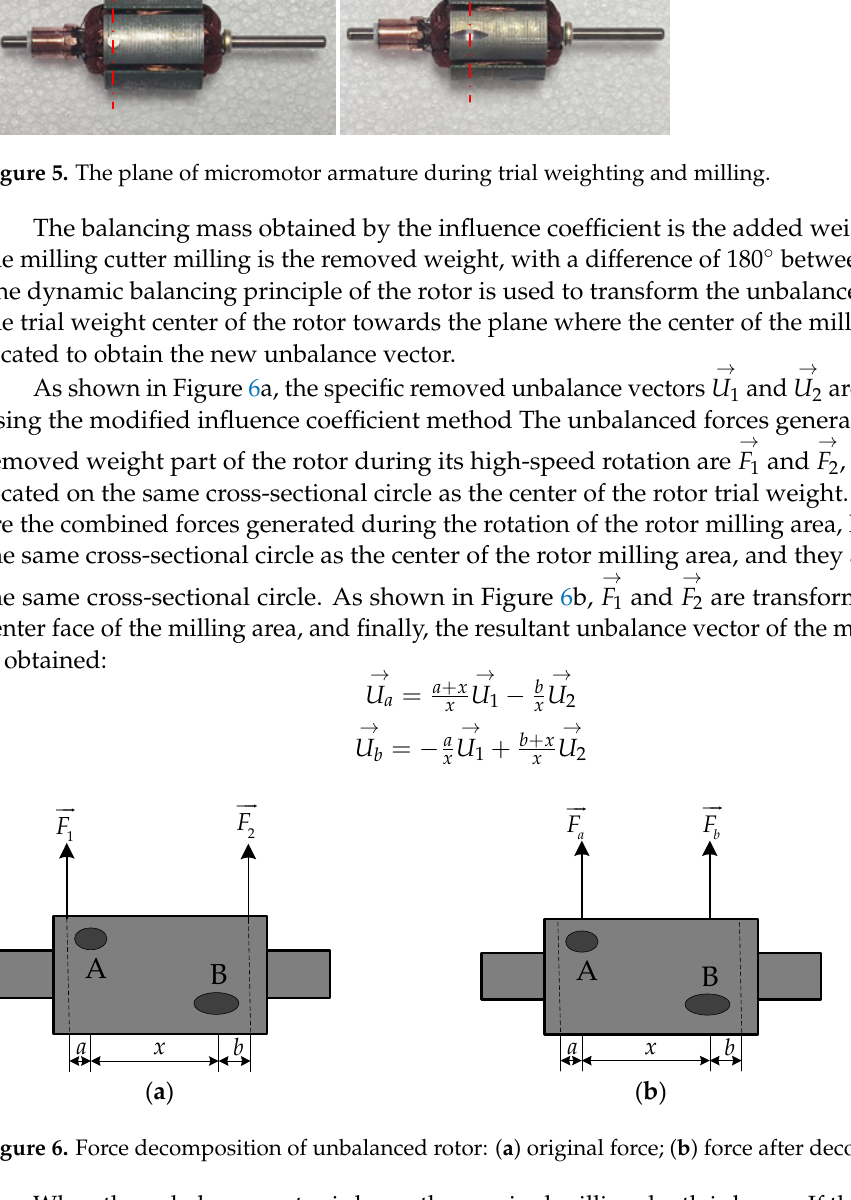
8 of 16 Table 1. Micro-motor armature and milling cutter parameters. Description